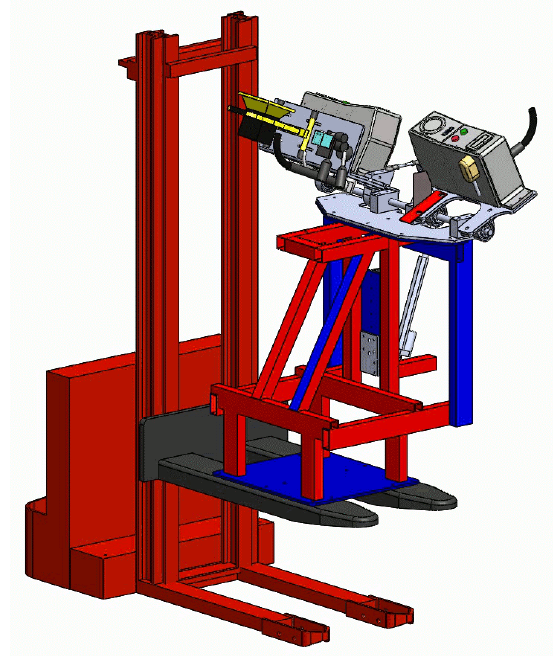
Figure 2. Prototype design: view of the stacker equipped with the mobile platform supporting two interdependent LCMS sensors.